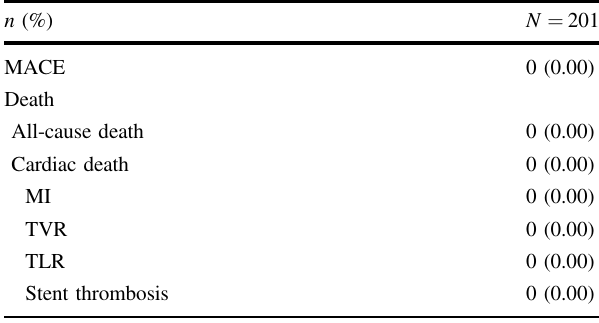
Table 3 Interim-analysis results at 1-month